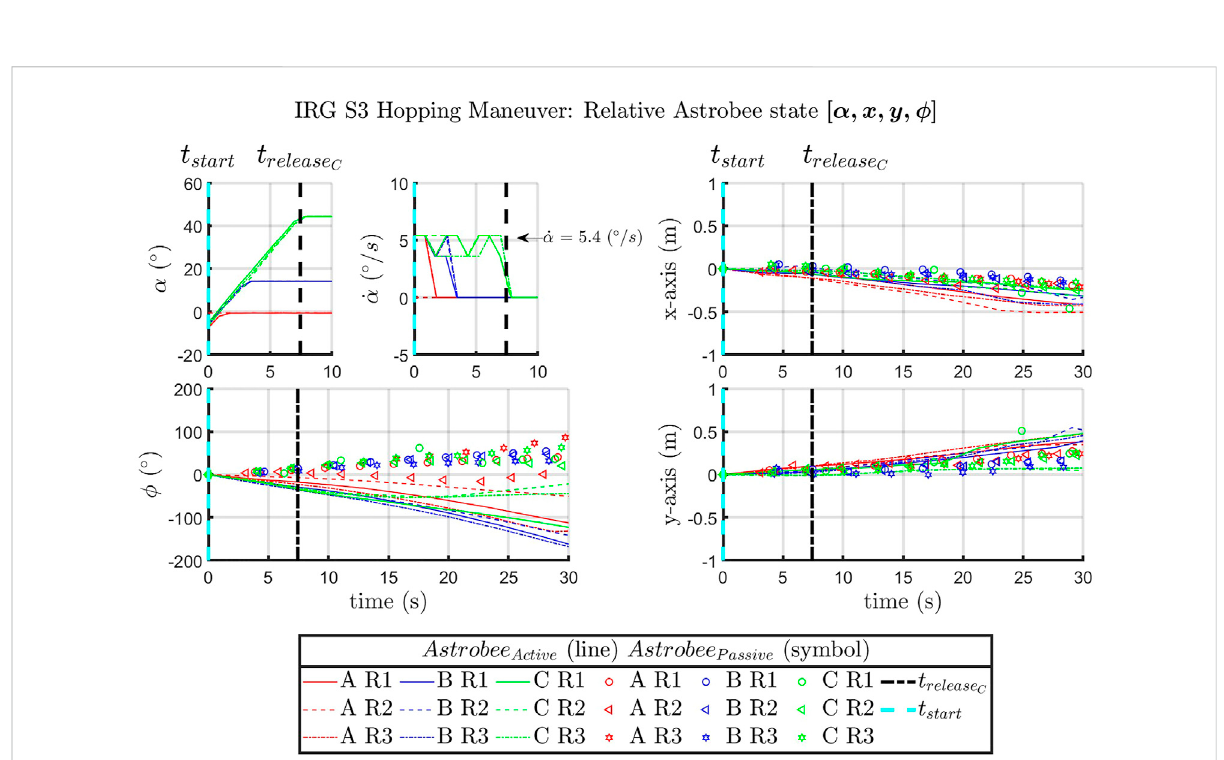
FIGURE 7 IRG [ α , x , y , ϕ ] for the Astrobee Active vehicle over time, with the time markers for t start of the proximal joint actuation.